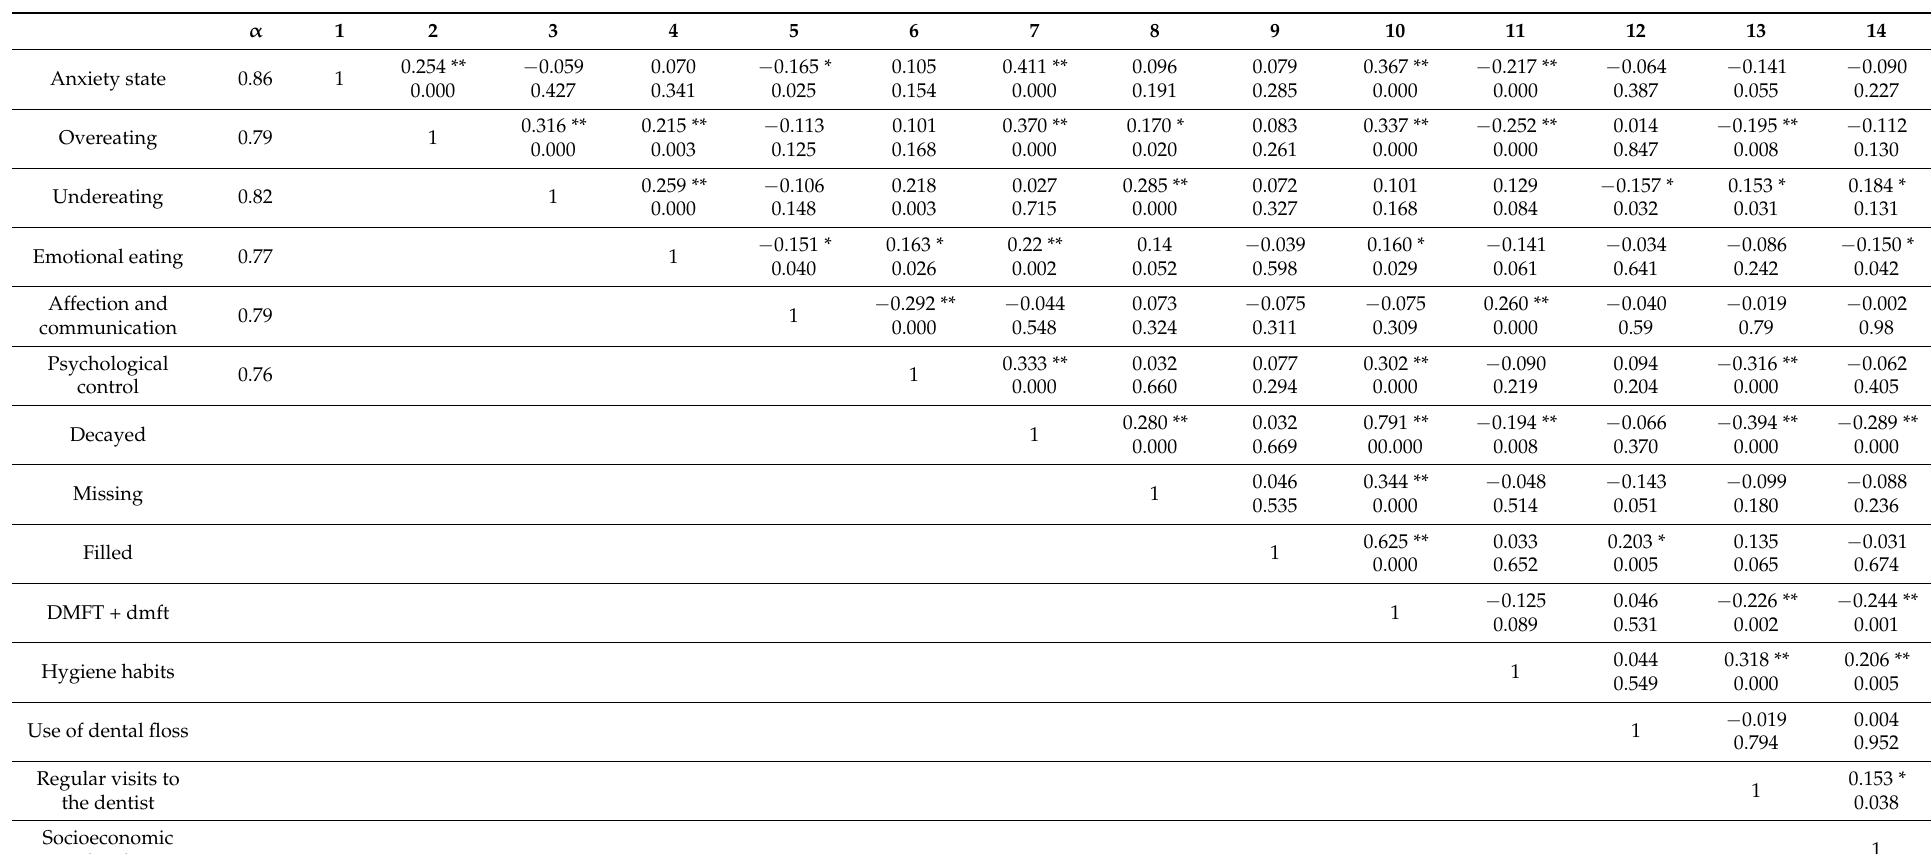
Table 2. Pearson’s Correlation between decayed, missing, filled, DMFT + dmft, anxiety state, overeating, undereating, emotional eating, affection and communication, promotion of autonomy, hygiene habits, use of dental floss, regular visits to dentist, and socioeconomic